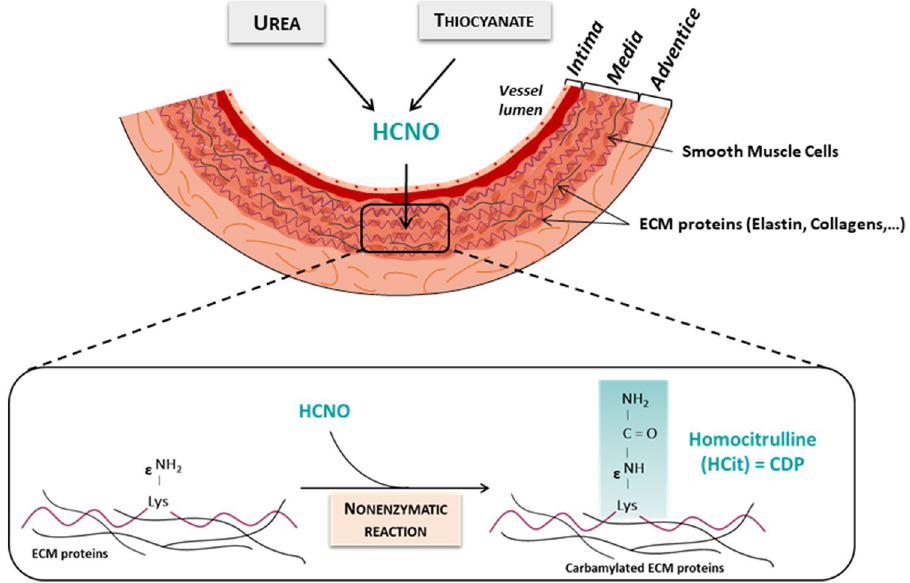
Figure 1. Schematic representation of extracellular matrix protein carbamylation within the arterial wall. CDP carbamylation-derived product, ECM extracellular